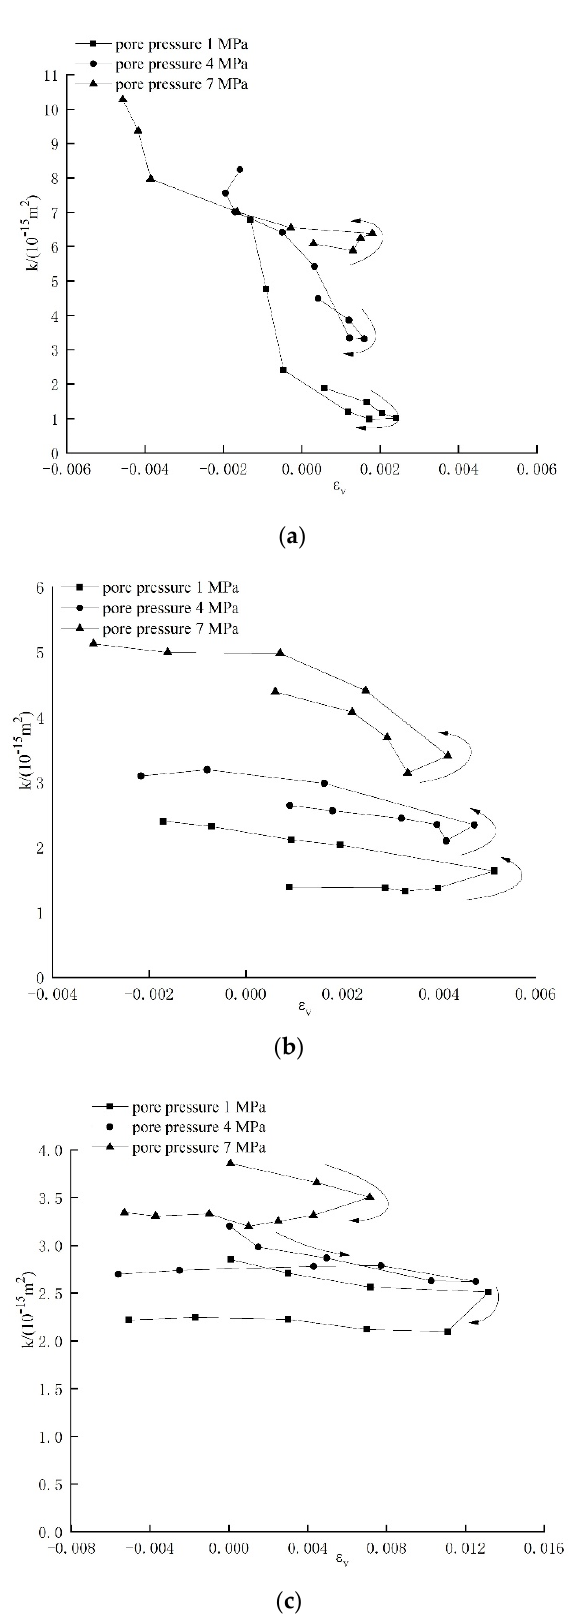
Figure 10. Relationship between permeability and volumetric strain of sandstone under different confining pressures. ( a ) Confining pressure 10 MPa; ( b ) confining pressure 20 MPa; ( c ) confining pressure 30 MPa.